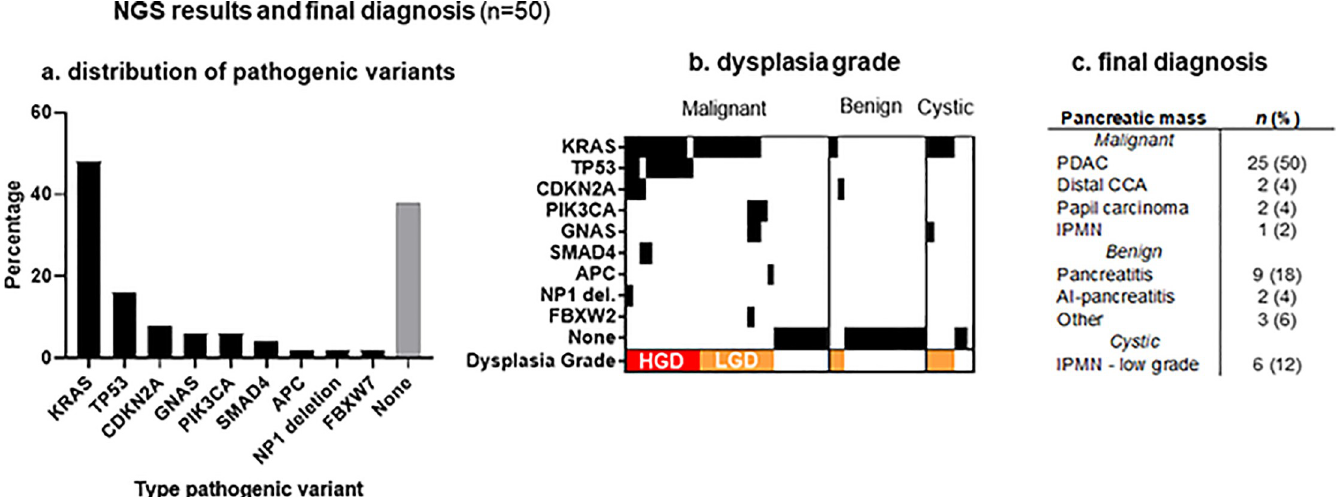
Fig 2. Pathogenic variants identified in 50 patients.